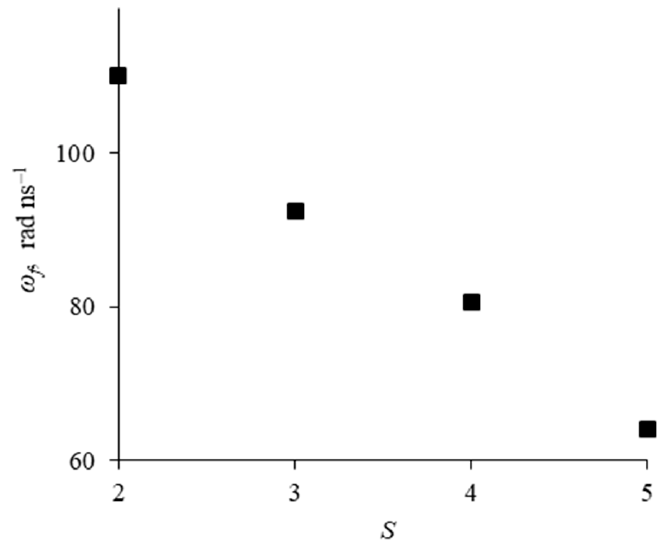
Figure 4. Dependence of the average angular speed of π -rotation on the number of molecules in a cluster.